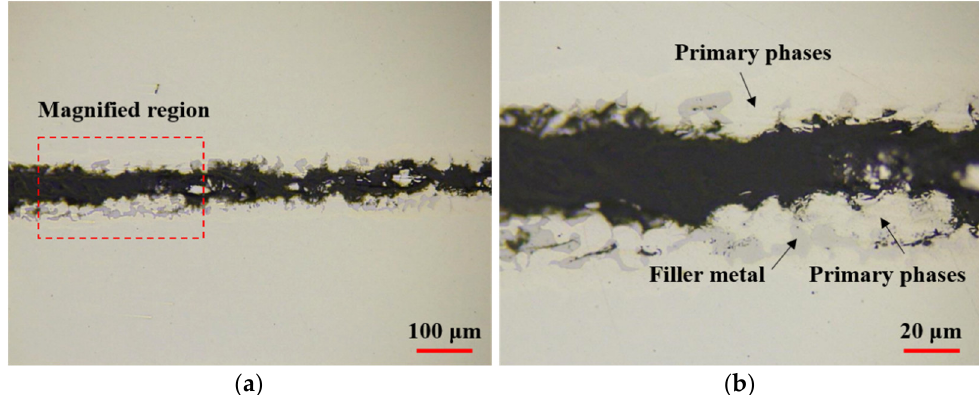
Figure 9. OM images of cross section of fractured joint brazed with electrodeposited Ni-13.4Cr-11.6P alloy coating. ( b ) is magnified region in ( a ).